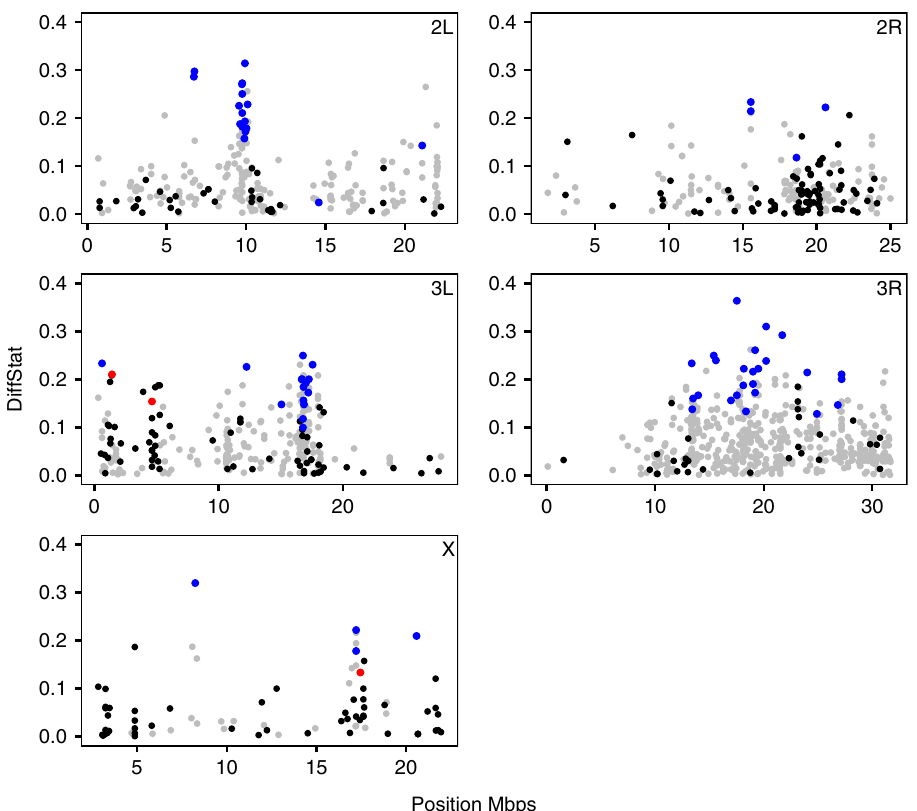
Fig. 1 DiffStat by position across each of the fi ve major chromosome arms. Black points indicate when the expected heterozygosity ( H e ) of the four success- selected lines is higher than the four failure-selected lines. Red points represent the same pattern for signi fi cantly diverged variants (SDVs). Grey and blue points are when the H e is higher in failure-selected lines for non-SDVs and SDVs,